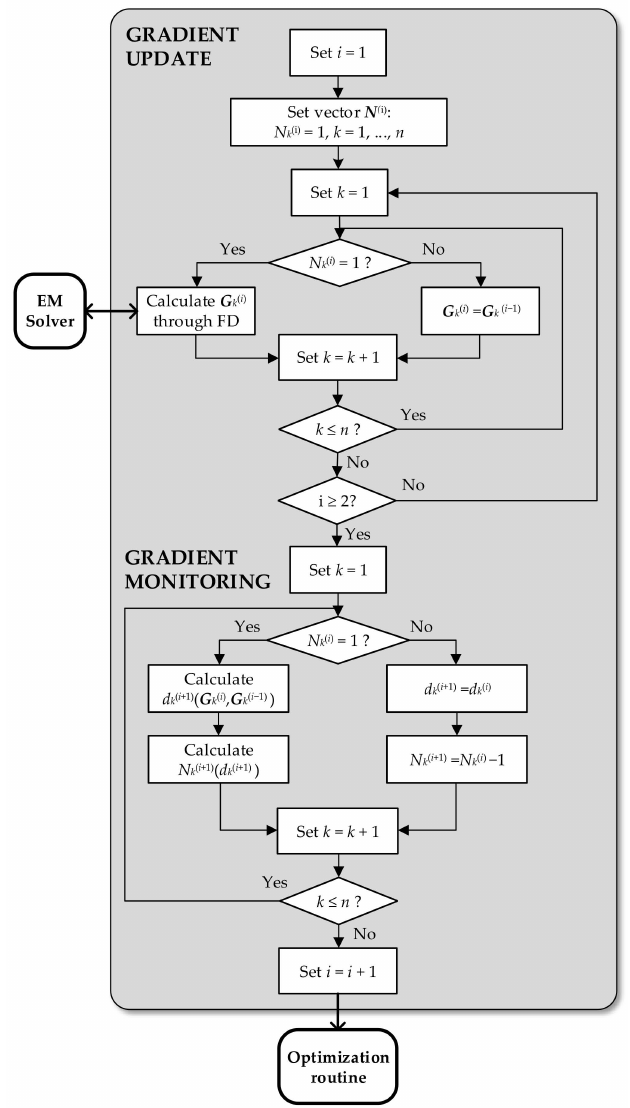
Figure 2. Flow diagram of the proposed sensitivity update routine with gradient change